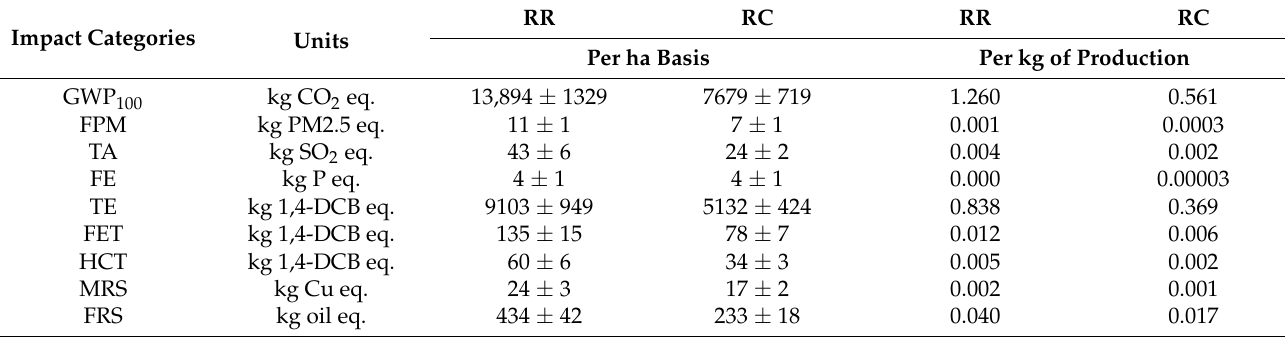
Table 4. Life cycle environmental impacts assessed per 1 ha basis and per kg basis for rice–rice and rice–cowpea